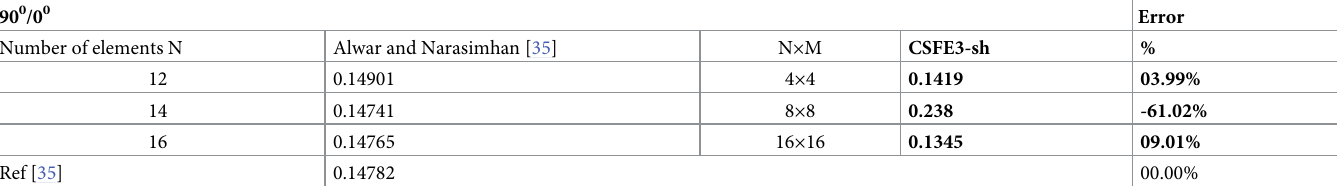
Table 6. Maximum deflection ( W 0 ) of the spherical composite shell embedded under internal pressure uniformly distributed. 90 0 /0 0